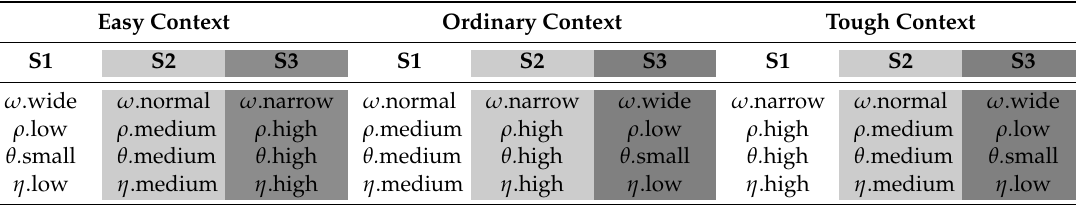
Table 2. Saliency of context messages in different road contexts.